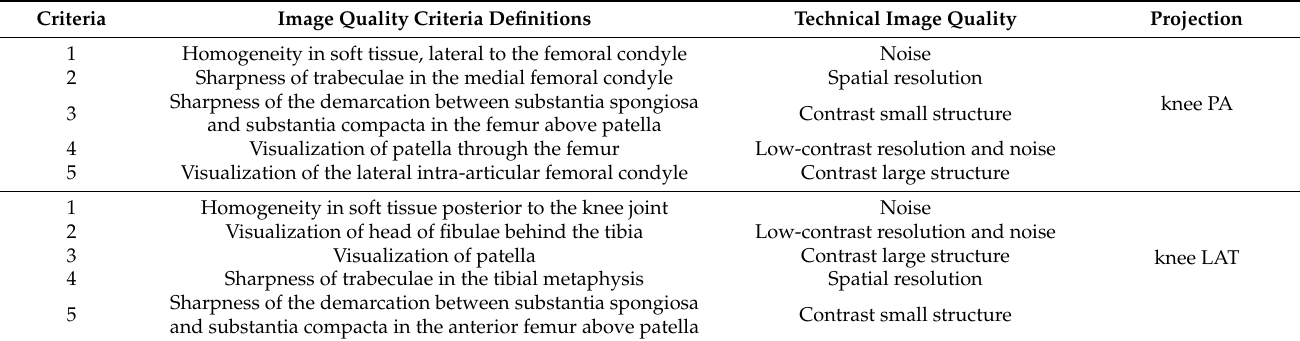
Table 5. Image quality criteria for the knee examination protocol in both PA and LAT